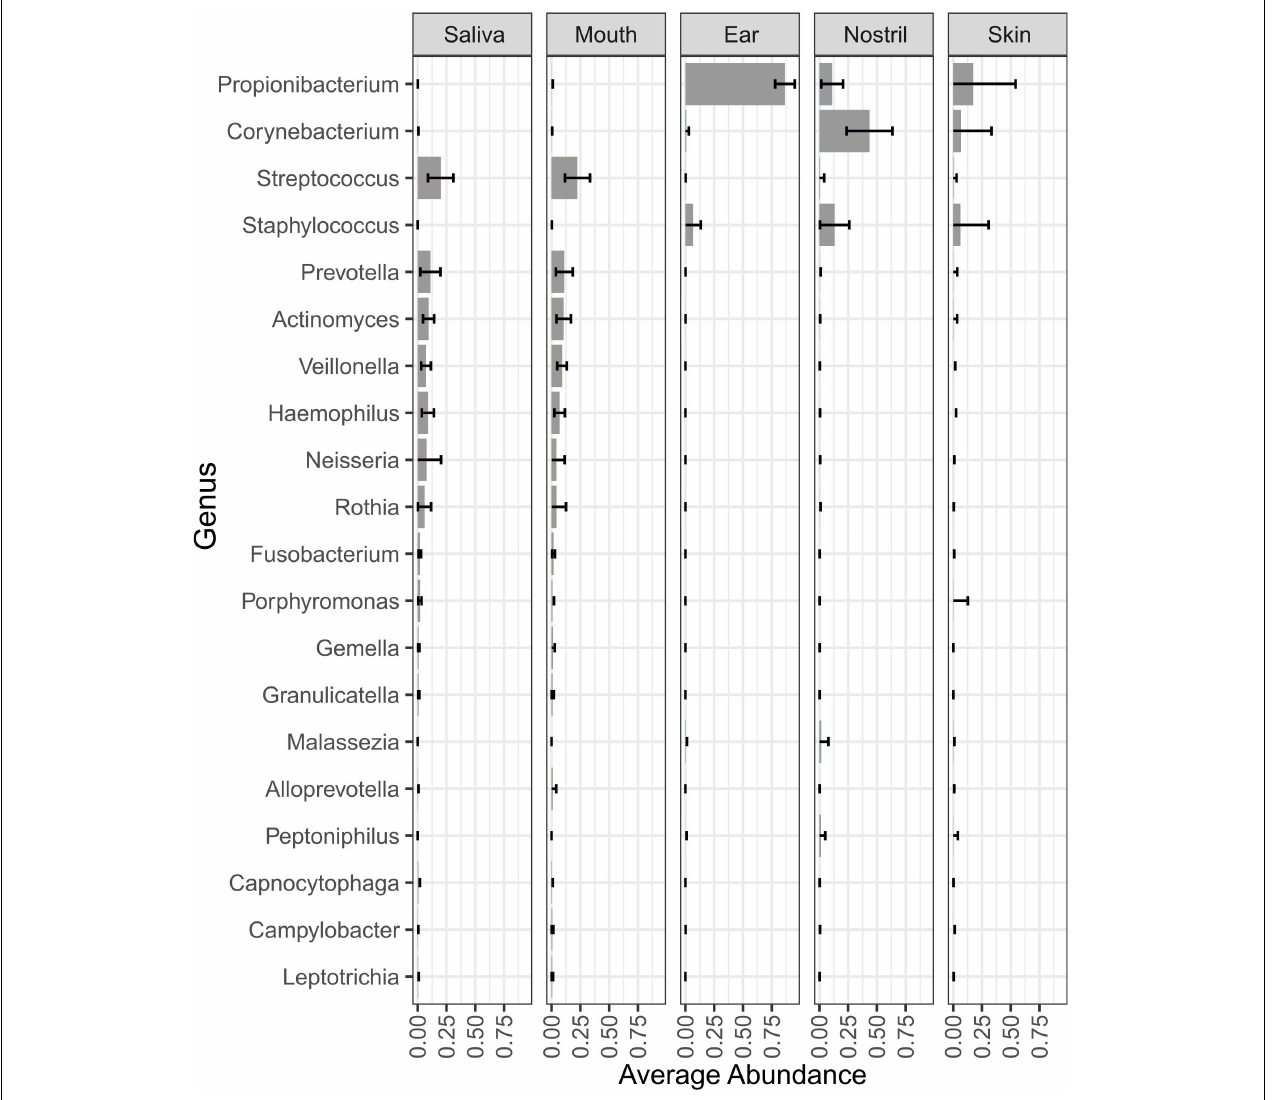
FIGURE 2 | Genera with an average relative abundance of at least 1% across all body locations from all four astronauts. The bars in each column represent the average relative abundance of that genus across all samples from that body